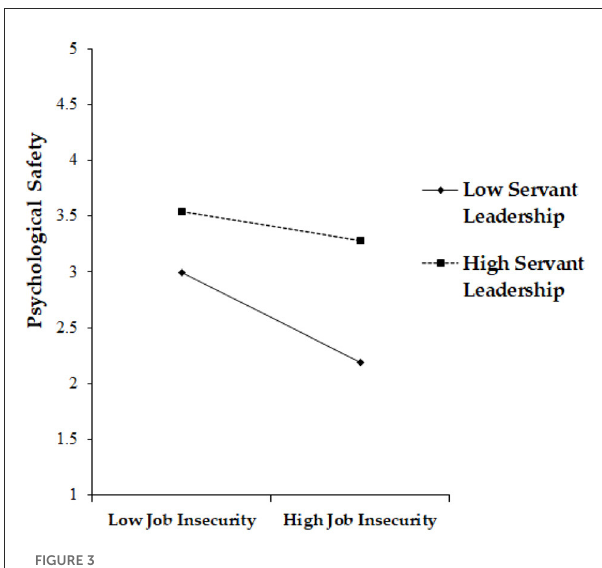
FIGURE3 Moderating effect of servant leadership in the job insecurity–psychological safety link.